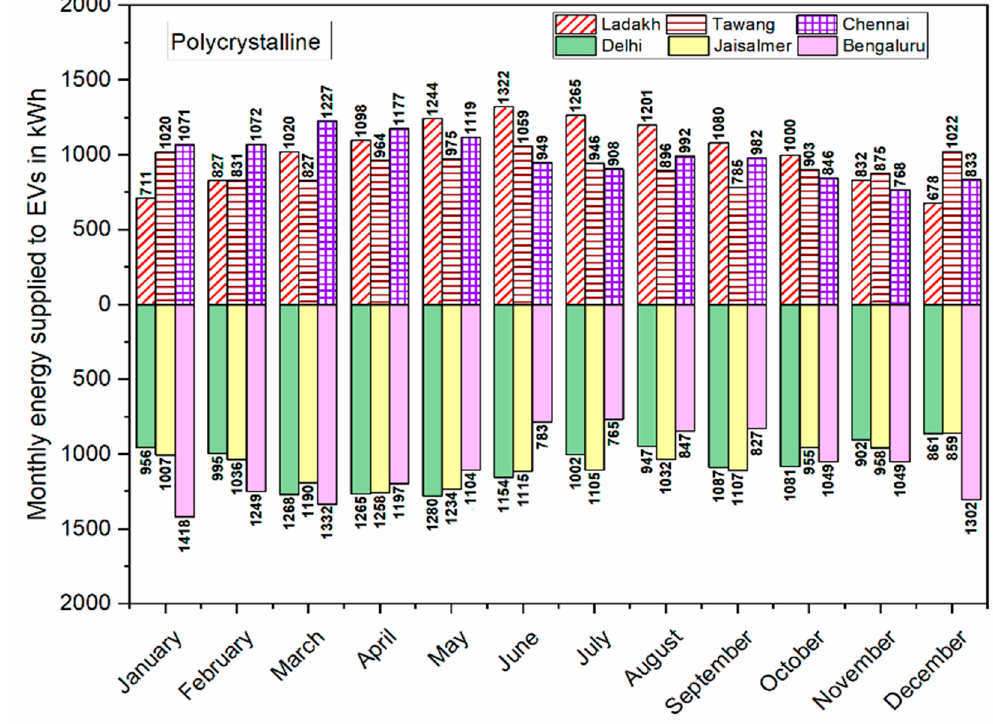
Figure 13. Monthly variation in energy supplied to EVs by the charging station using polycrystalline modules .